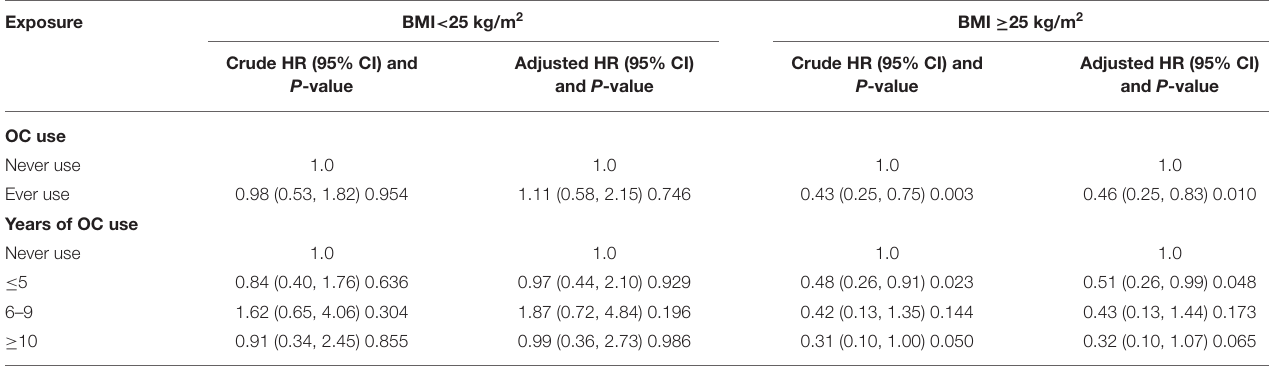
TABLE 3 | OC use and glioma risk according to BMI in the PLCO trail. Exposure